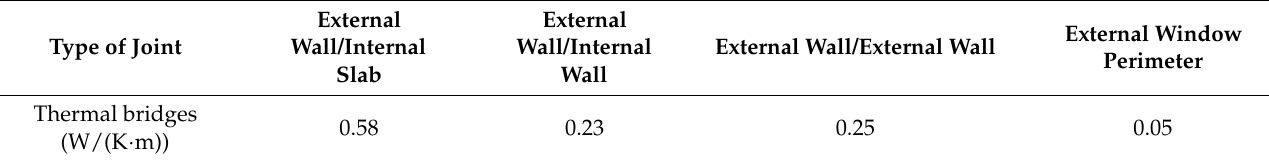
Table 2. Linear heat loss coefficient of thermal bridges (W/(K · m)) for different types of joints in building. Table 4. Internal gains in building.